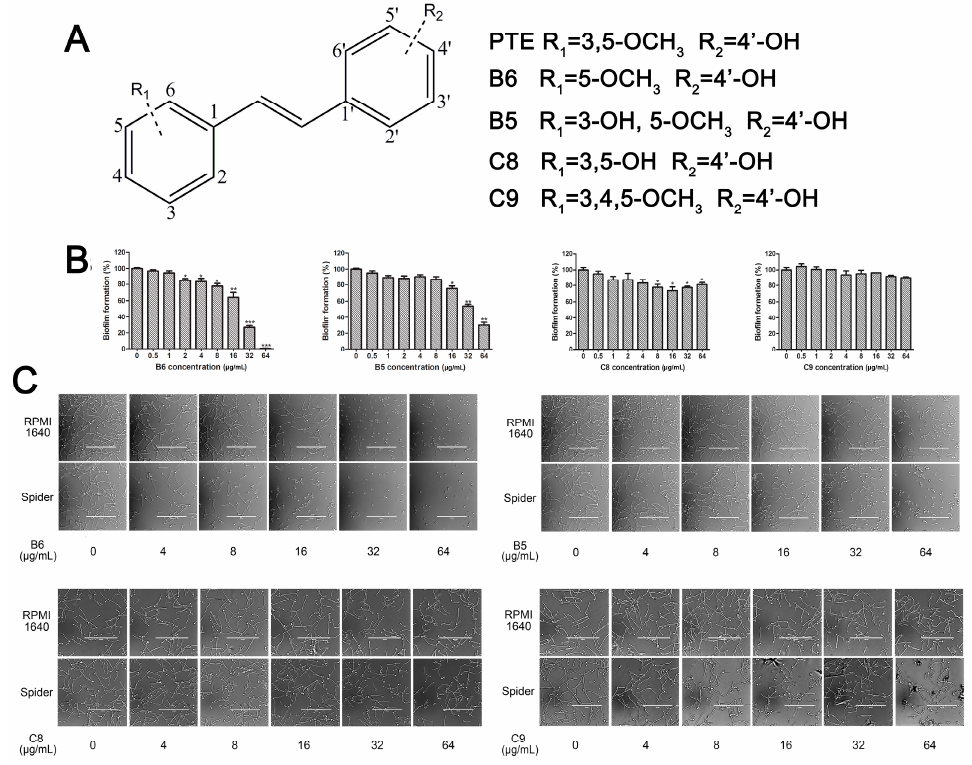
Figure 5. Effects of different concentrations of analogues B6, B5, C8. and C9 on biofilm formation and hyphal formation. ( A ) Chemical structures of analogues B6, B5, C8, and C9 are shown. B6, B5, C8, and C9 are different from PTE in partition C; ( B ) Effects of different concentrations of analogues B6, B5, C8, and C9 on biofilm formation. Biofilm formation results represent the mean ± standard deviation for three independent experiments. * p < 0.05 compared with the control biofilms, ** p < 0.01 compared with the control biofilms, *** p < 0.001 compared with the control biofilms. Statistical analysis was performed to compare the effects of various compounds, and significant difference was observed upon B5, C8, and C9 compared with PTE. p = 0.182 (B6 vs. PTE), p = 0.041 (B5 vs. PTE), p < 0.001 (C8 vs. PTE), and p < 0.001 (C9 vs. PTE); ( C ) Effects of different concentrations of analogues B6, B5, C8, and C9 on hyphal formation. Scale bar = 100 μ m.